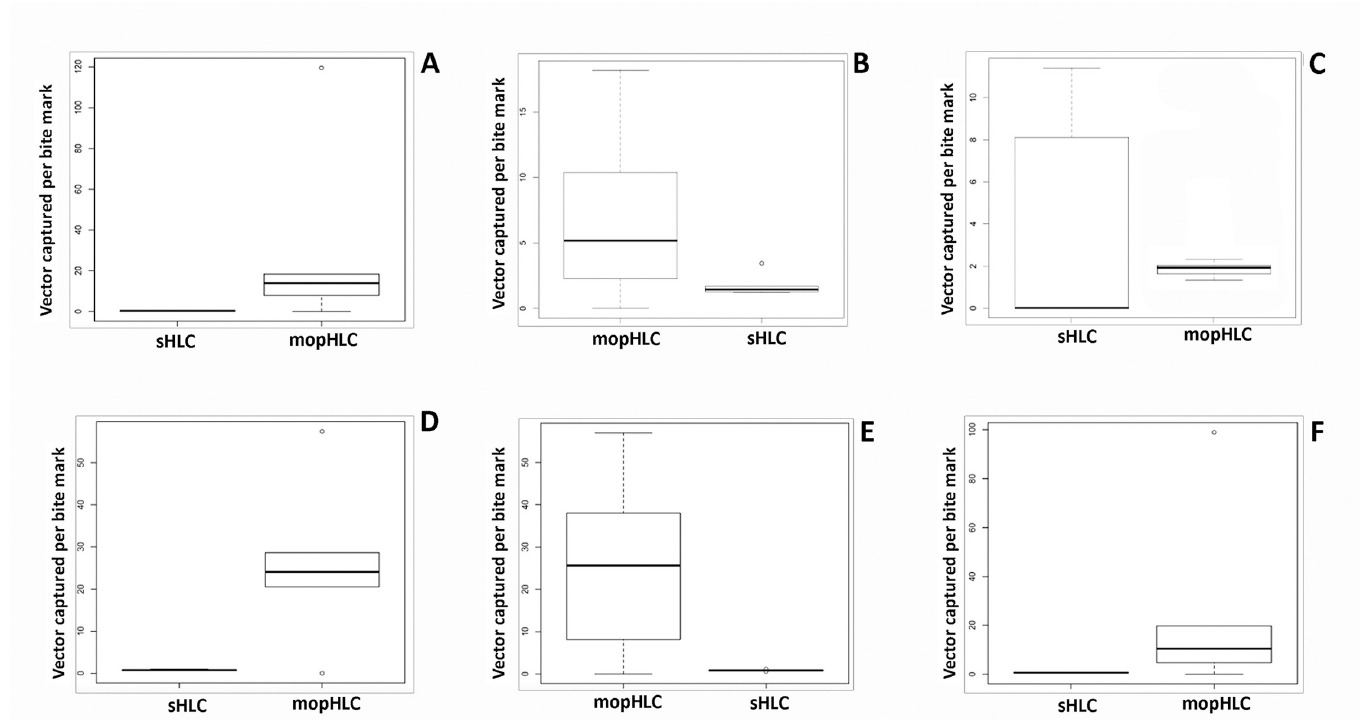
Fig 7. Shows box plots comparing SC/CBMs calculated for mopHLC and sHLC trapping. The S/CBM box plots were prepared individually from each of our six vector collectors collection data. Graphs A-F correspond to data taken from the vector collectors´ legs shown in Figs 2 and 3 (plates A-F) and are labelled in the same way. The raw collection data used to prepare these graphs is shown in Table